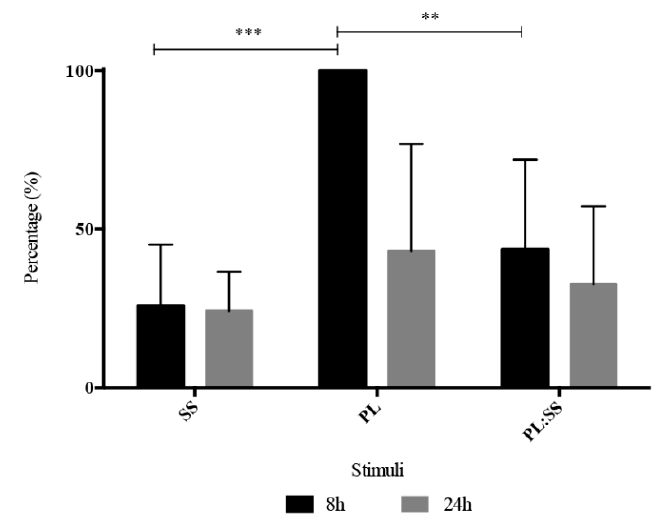
Figure 6. WB analysis of Cyclin D1. Level of Cyclin D1 expression 8 and 24 h after stimulation of synchronized BMSC with SS, PL and with PL:SS. Results are expressed as percentage of the highest expression observed 8 h after stimulation with PL. Levels of Cyclin D1 expression were determined by Western Blot. We performed WB analysis on three different primary cell cultures, *** p < 0.001, ** p < 0.01.